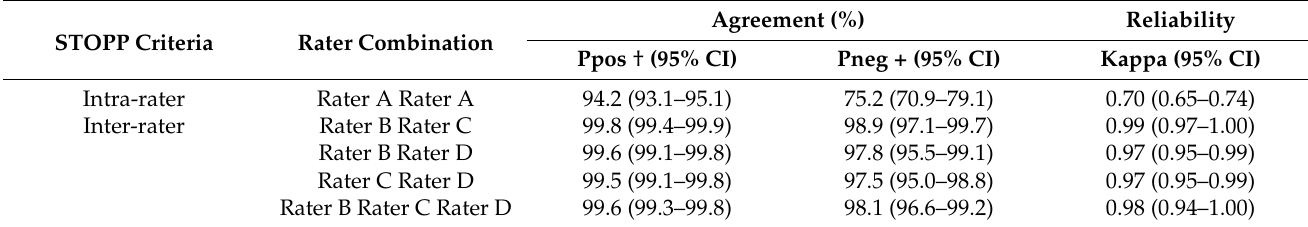
Table 2. Intra- and inter-rater reliability and agreement based on the analysis of the STOPP criteria.